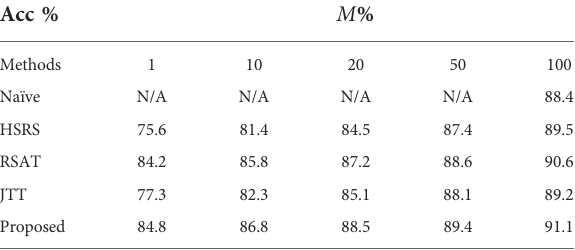
TABLE 4 Test accuracies of our approach and baselines when the ratio of the size D store vs. the size of D train changes. Acc % M